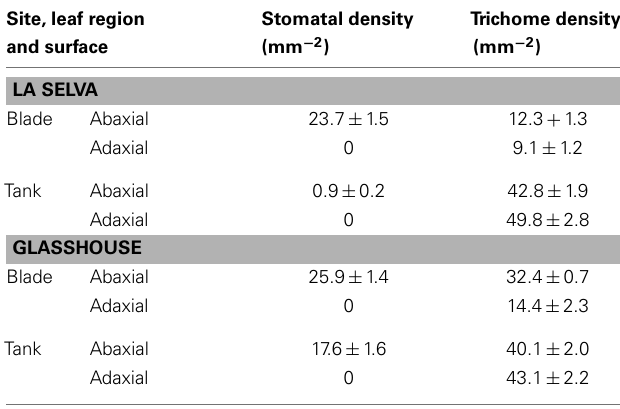
Table 2 | Stomatal and trichome densities for leaves of G.